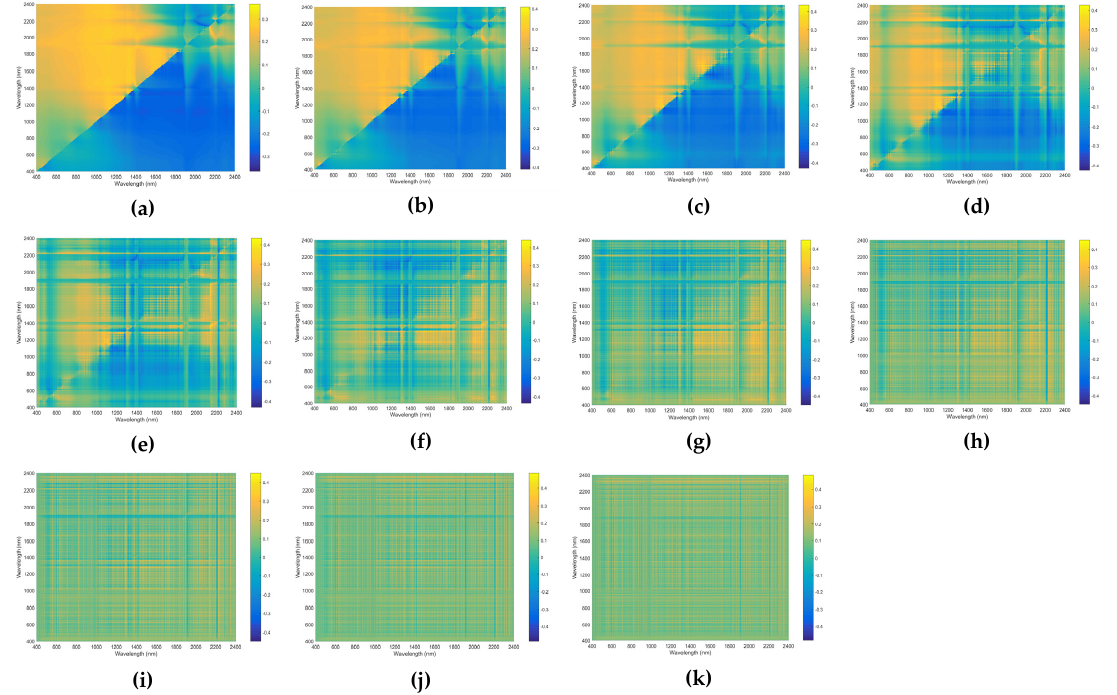
Figure A2. Correlation coefficients between soil Hg and difference index of the reflectance processed by ( a ) 0-order, ( b ) 0.2-order, ( c ) 0.4-order, ( d ) 0.6-order, ( e ) 0.8-order, ( f ) 1-order, ( g ) 1.2-order, ( h ) 1.4-order, ( i ) 1.6-order, ( j ) 1.8-order, ( k ) 2-order.